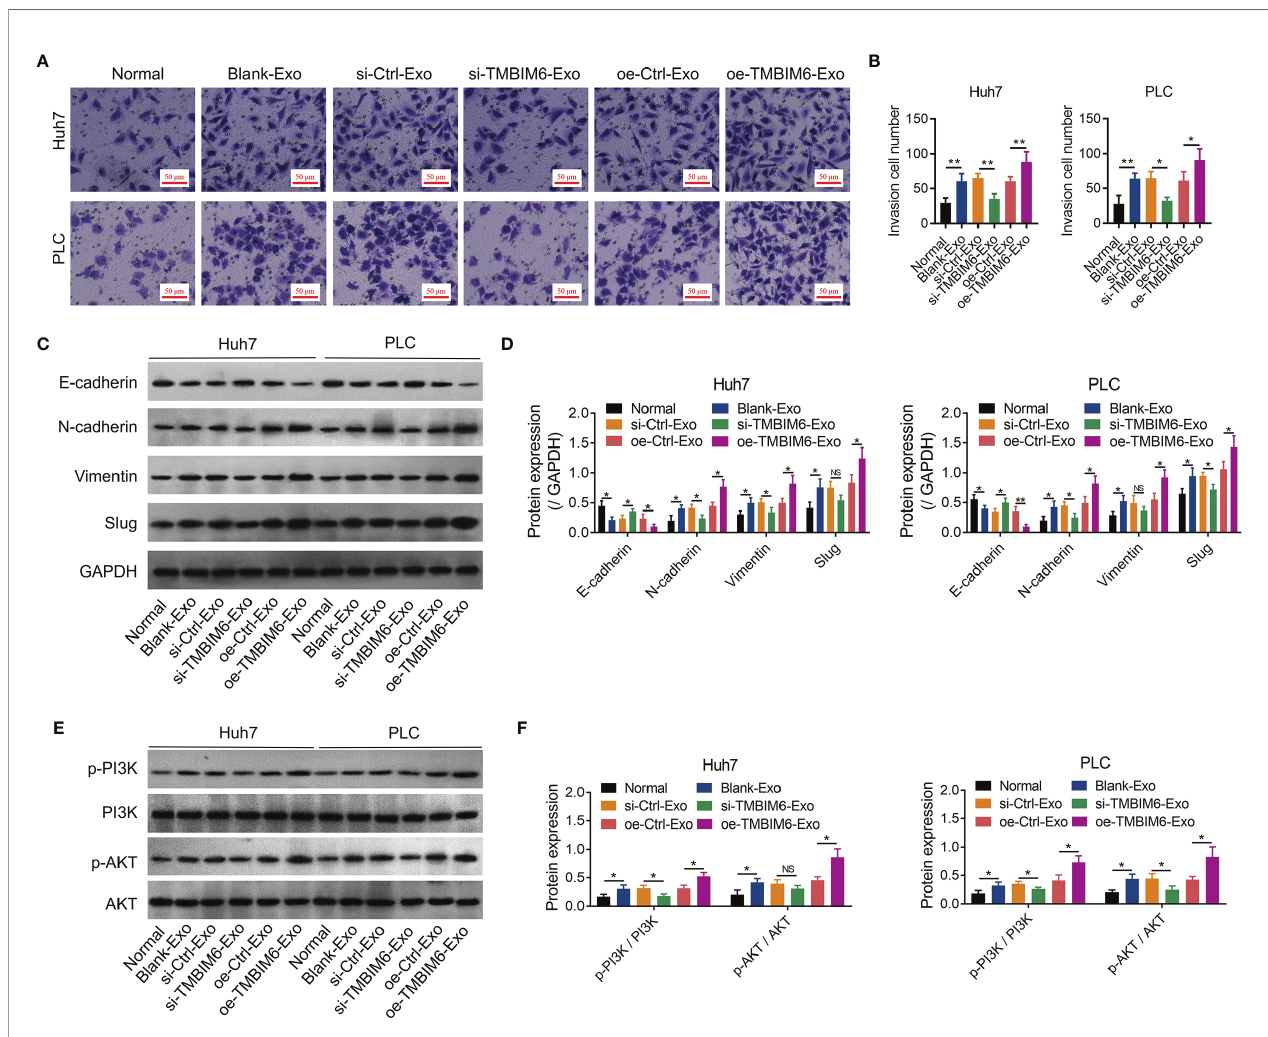
FIGURE 7 | Effect of exosomes from TMBIM6-modi fi ed HCC-MSCs on invasion, EMT markers, and PI3K/AKT pathway in HCC cells. Comparison of invasion (A, B) , EMT markers (C, D) , and phosphorylation of PI3K and AKT (E, F) among groups in Huh7 and PLC cells. HCC-MSCs were cultured normally or transfected with control siRNA, TMBIM6 siRNA, control overexpression plasmids, or TMBIM6 overexpression plasmids; then HCC cells were cultured normally or co-cultured with exosomes from TMBIM6- modi fi ed HCC-MSCs. Purple cells indicate invaded cells in panel (A) . NS, not signi fi cant; * p < 0.05; ** p < 0.01. HCC, hepatocellular carcinoma; MSCs, mesenchymal stem cells; EMT, epithelial – mesenchymal